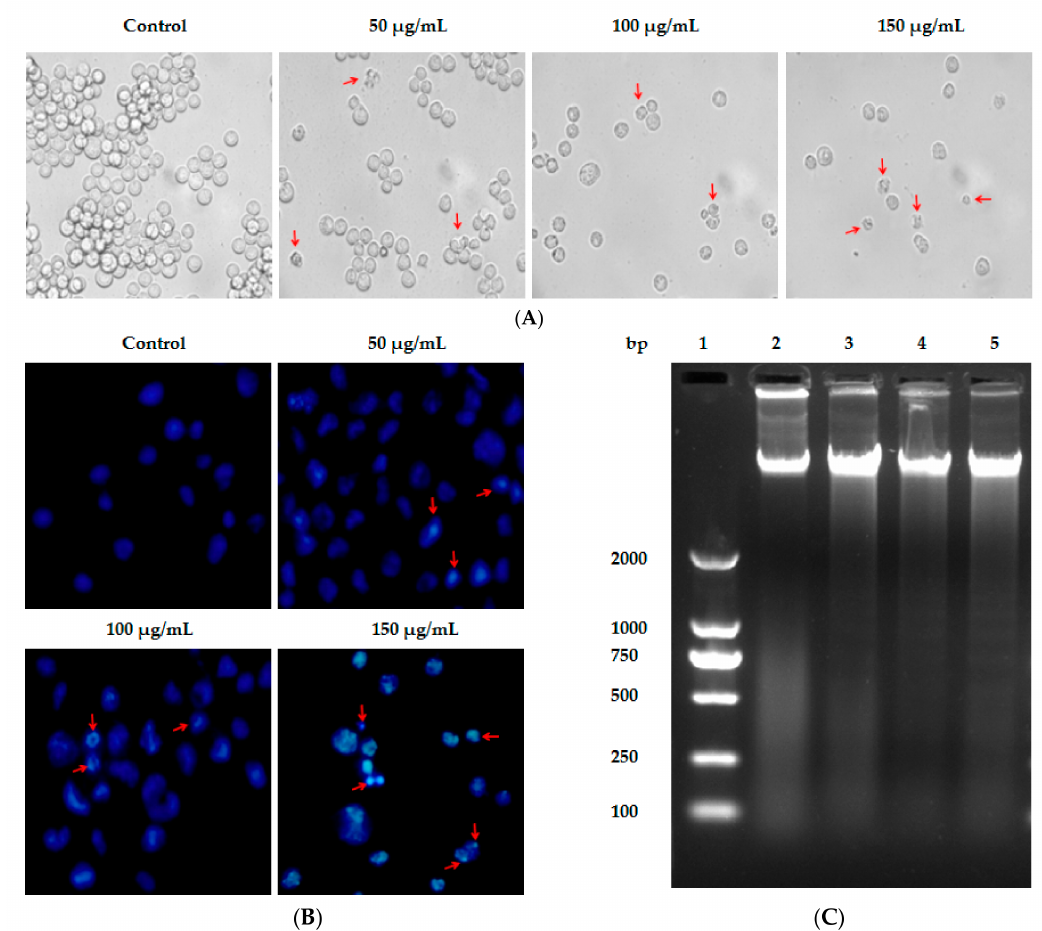
Figure 1. Lp16-PSP-induced cytotoxicity, nuclear morphological change and DNA fragmentation in acute promyeloid leukemia (HL-60 cells). ( A ) Phase contrast image of HL-60 cells, untreated and treated samples after 48 h of Lp16-PSP treatment. Red arrowheads are indicating the cells smaller in size and also showing cellular bleeding at 40 × magnification; ( B ) fluorescent images of Hoechst 33258 stained HL-60 cells for nuclear morphological changes after 48 h of Lp16-PSP treatment with indicated concentrations at 40 × magnification; and ( C ) DNA fragmentation of HL-60 cells treated with 0 µ g/mL, 50 µ g/mL, 100 µ g/mL, and 150 µ g/mL of Lp16-PSP for 48 h. Lane 1: DNA marker DL2000; lane 2: 0 µ g/mL; lane 3: 50 µ g/mL; lane 4: 100 µ g/mL; and lane 5: 150 µ g/mL Lp16-PSP exposed group. Results are representative of three independent